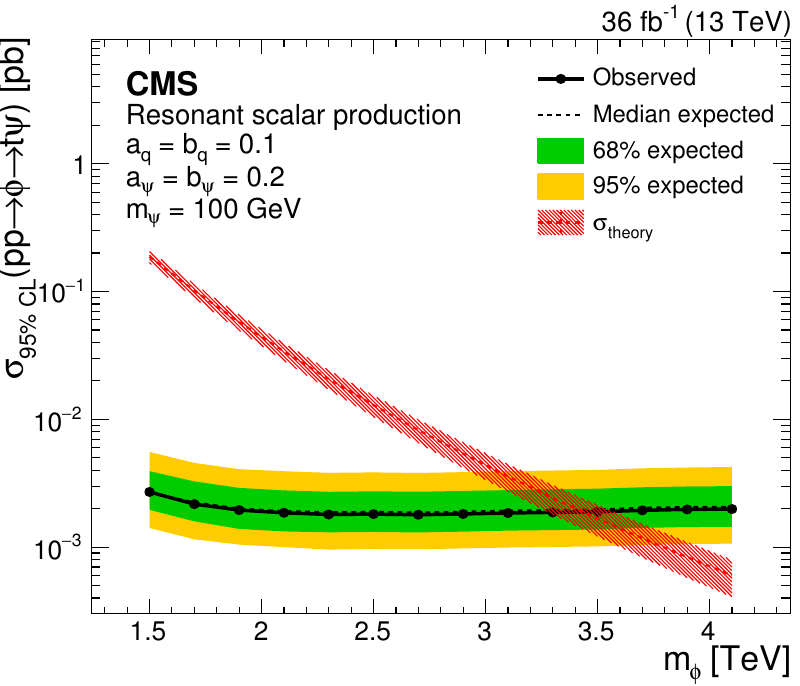
Figure 13 . Upper limits at 95% CL on the mass of the scalar particle (cid:30) in the resonant model, assuming (cid:12)xed a q = b q = 0 : 1 and a = b = 0 : 2. The green and yellow bands represent one and two standard deviations of experimental uncertainties, respectively. The red hatched band represents the signal cross section uncertainty as a function of m (cid:30) .